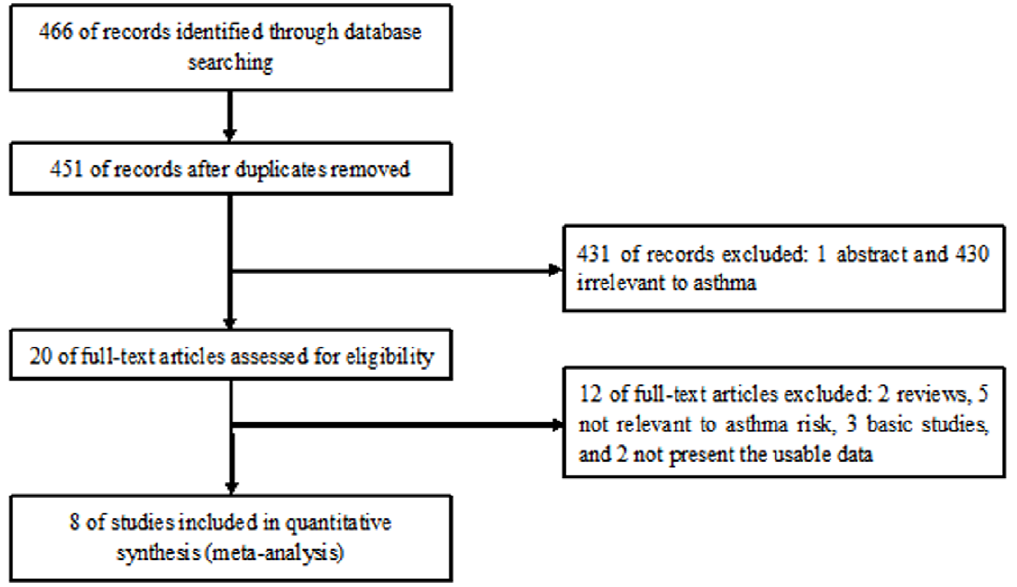
Figure 1. Flow of study identification, inclusion, and exclusion.